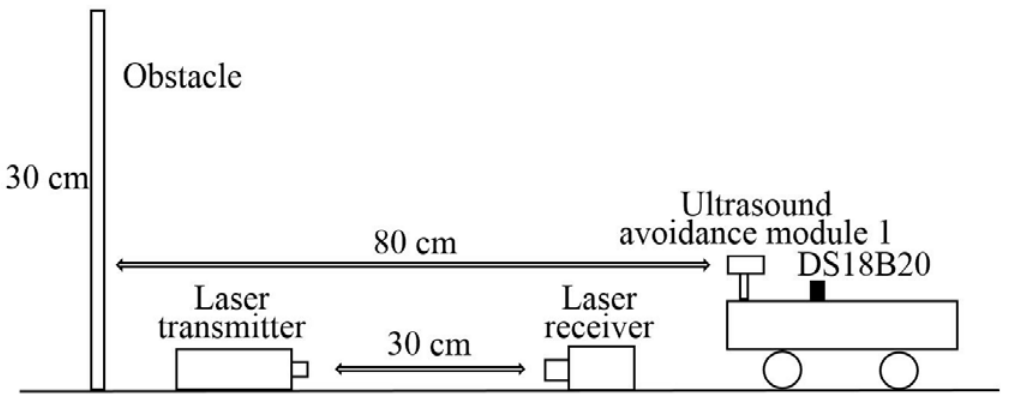
Figure 8. The layout of experimental equipment in the corridor.